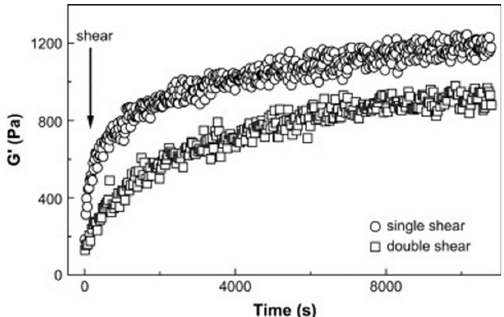
Figure 1. Recovery of the storage modulus versus time. Reprinted with permission from [50]. Copyright (2008) Elsevier.